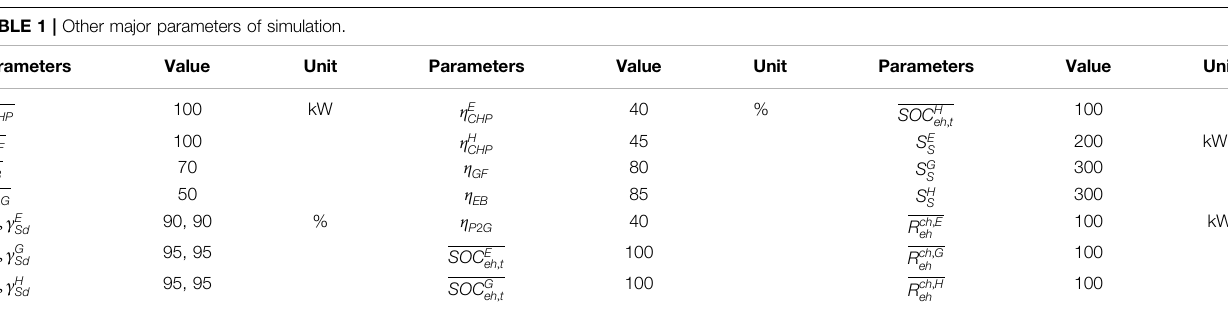
period 23:00 – 6:00 is off-peak price period. The retail prices of natural gas and heat in RM are the same in 24 h, which are 0.3 and 0.7 Yuan/kWh, respectively.